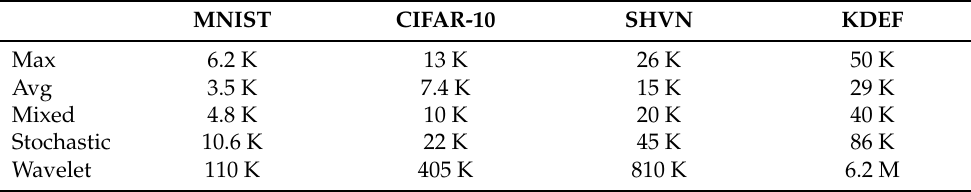
Table 1. A comparison of the total mathematical operations required per method [32].